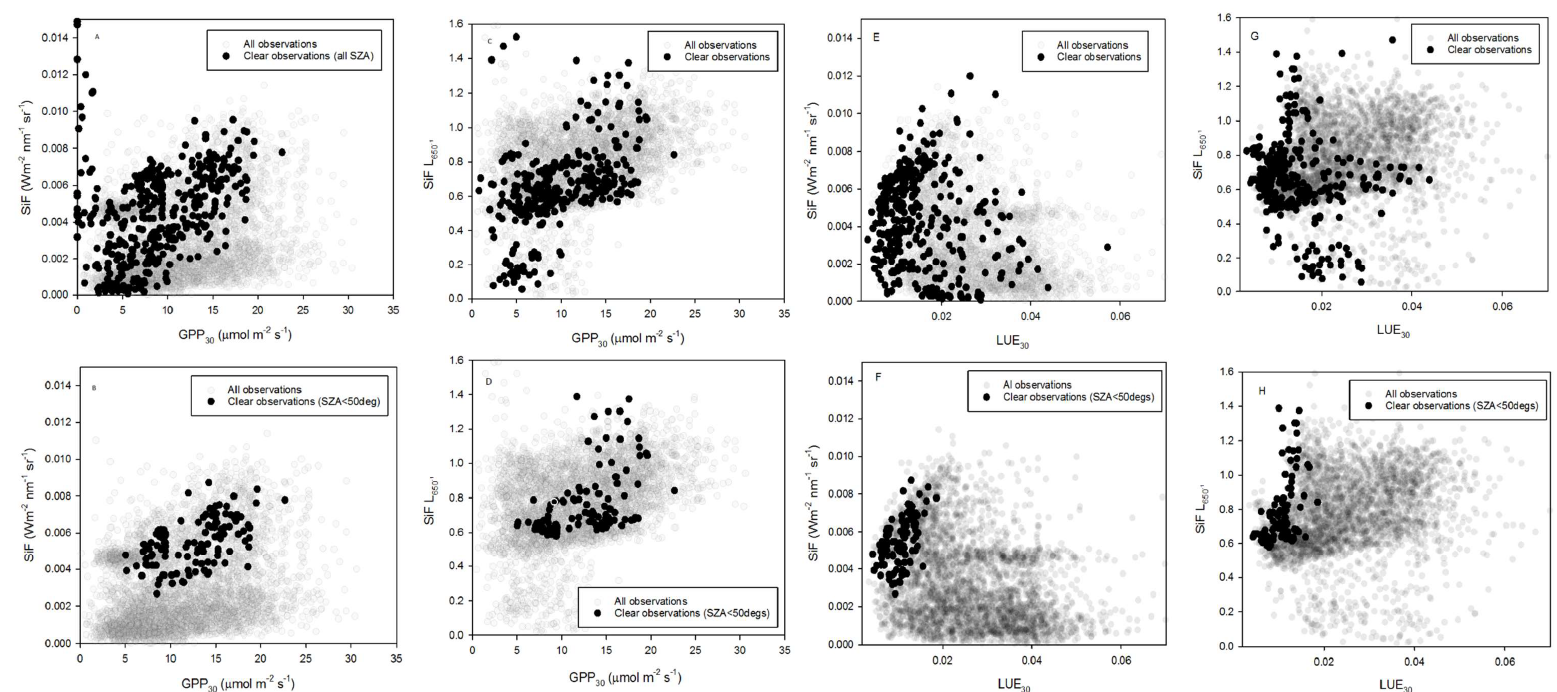
Figure 5. Relationships between SiF and SiF L 650−1 , and GPP 30 and LUE 30 (10–12 UTC). Grey circles include data acquired on clear and cloudy days as well as all solar angles. Black circles represent data acquired during clear days ( A , C , E , G ), and also when solar zenith angle was smaller than 50° (n = 118 for B and D , 116 for F and H ) on clear days ( B , D , F , H ).